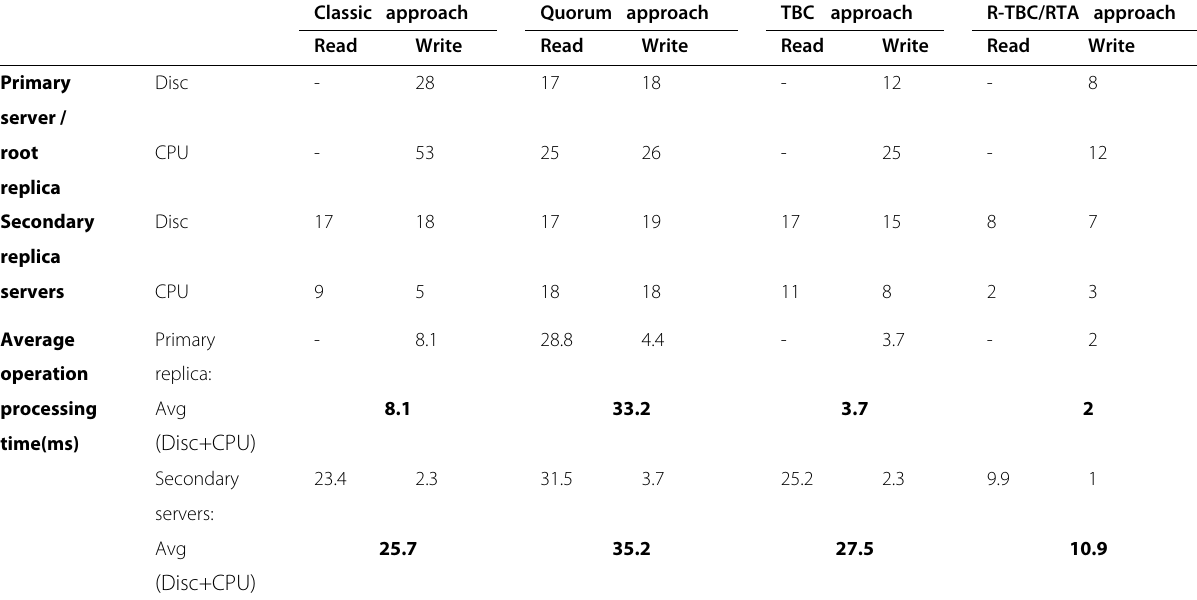
Table 3 The processing times (ms) of read/write operations (90/10 R/W ratio) for standard approaches (Classic, Quorum, TBC) and proposed advanced R-TBC/RTA approach for maintaining the consistency of the cloud DBMS Classic approach Quorum approach TBC